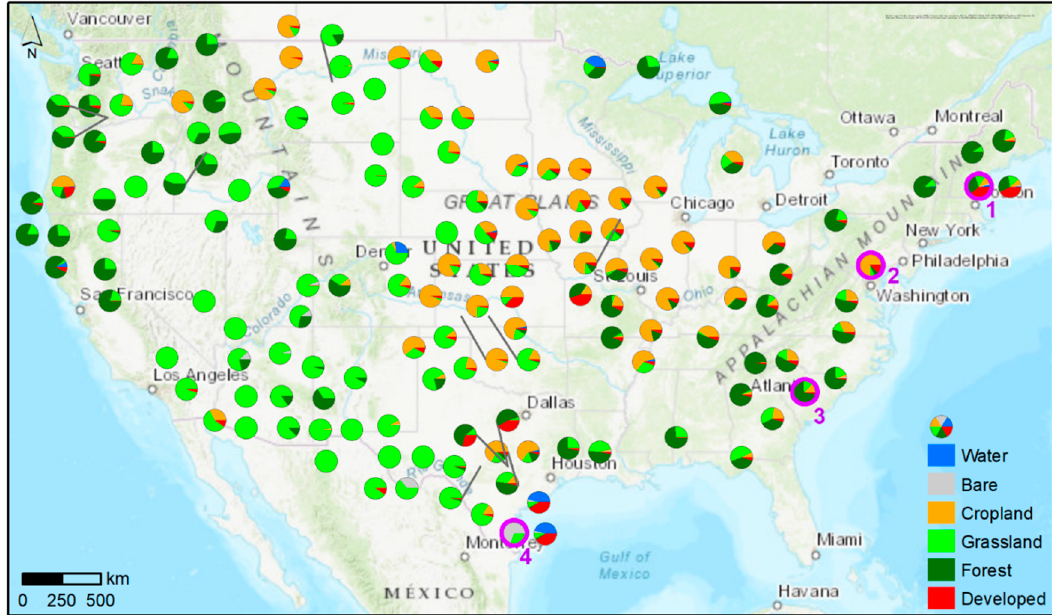
Figure 1. The overview of 150 study sites across the contiguous United States. Pie graphs indicate the land use pattern at each site. Purple circles indicate the four primary sites.